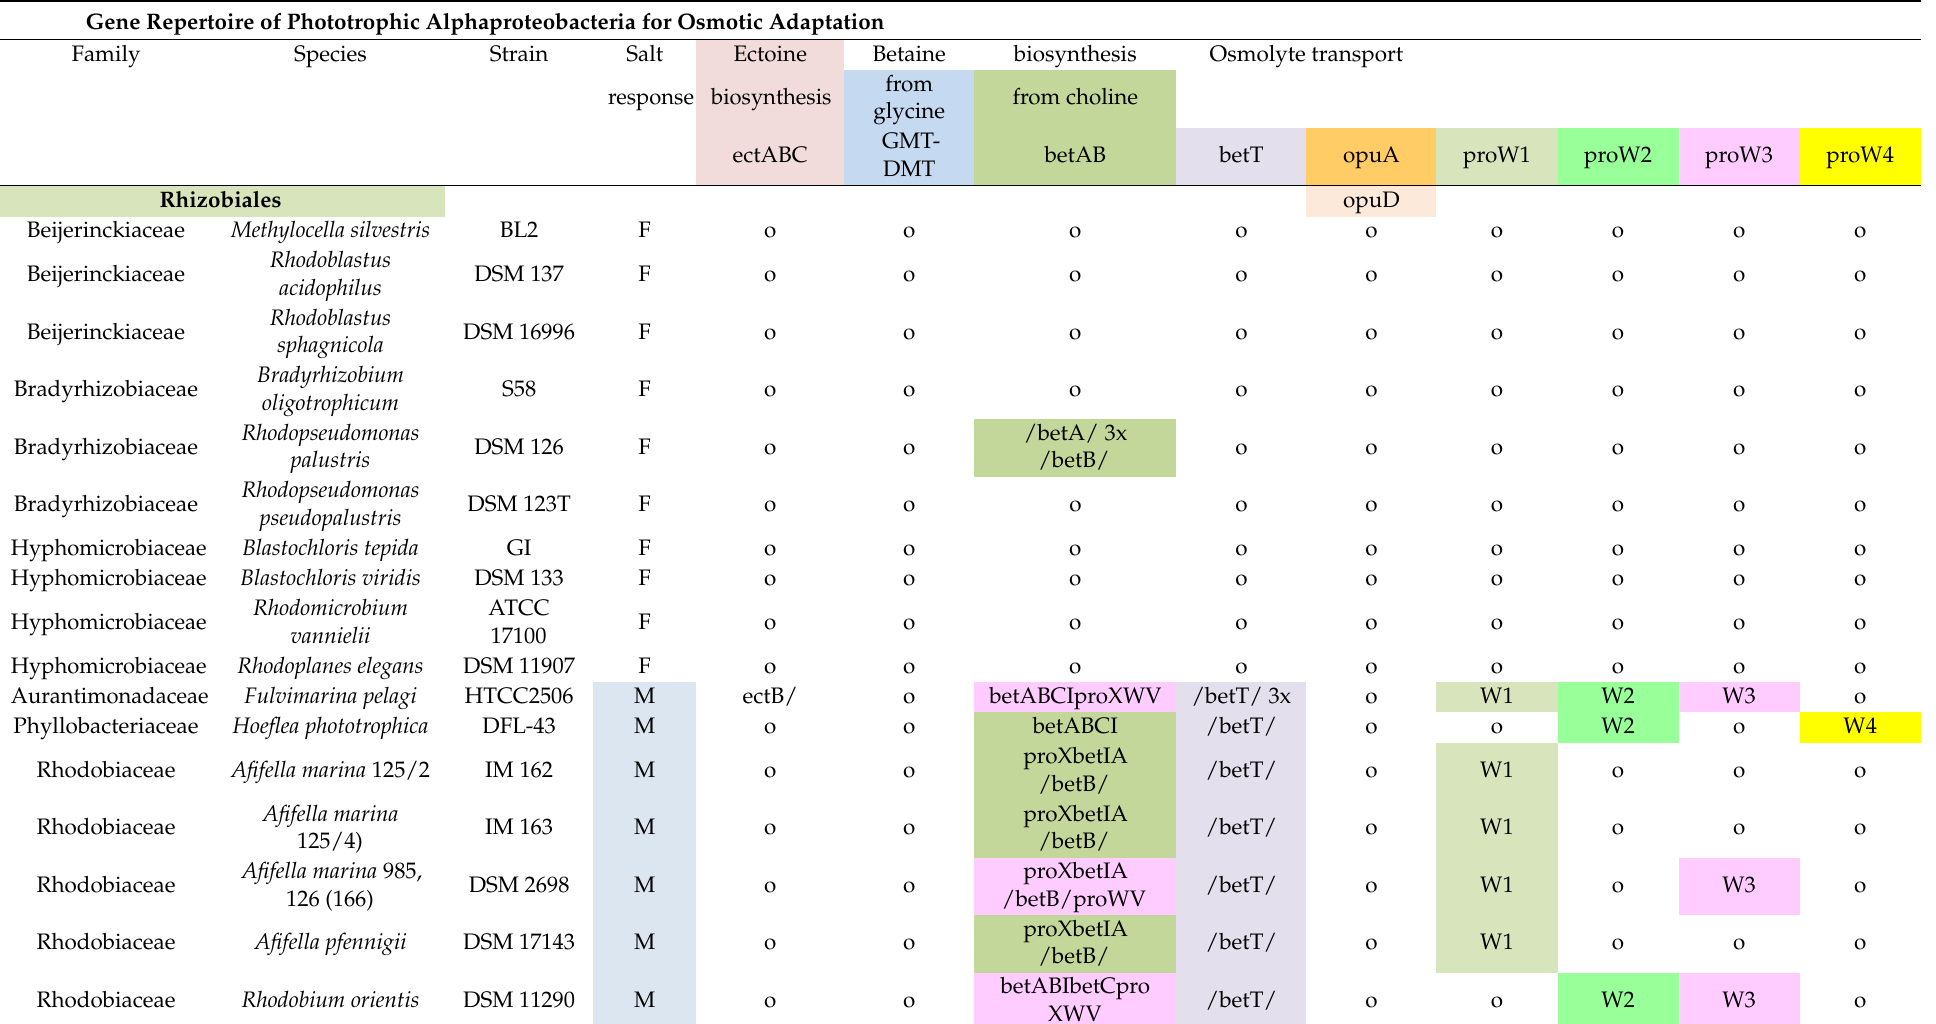
Table 2. Genes and gene clusters of betaine and ectoine biosynthesis as well as relevant transport systems of phototrophic Alphaproteobacteria a . Gene Repertoire of Phototrophic Alphaproteobacteria for Osmotic Adaptation